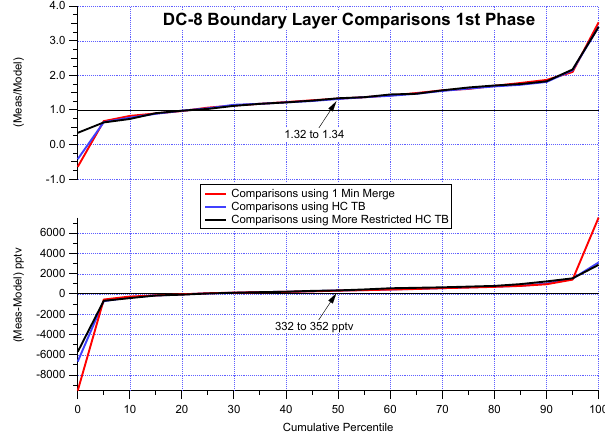
Fig. 3. Cumulative percentile measurement/model ratios (upper) and differences (lower) for DC-8 TDLAS-box model comparisons using the standard 1-min merged data set (red line), using the hy- drocarbon time base merge (HC TB, blue line), and using the more restricted data on the HC TB (black line), as further discussed in the text. The median ratios and differences highlighted reflect the range of values for the 3 merges. Large measurement-model discrepan- cies in both the ratios and differences only occur in the lowest and highest 5% of the distributions, indicating that comparisons are not highly dependent on the type of